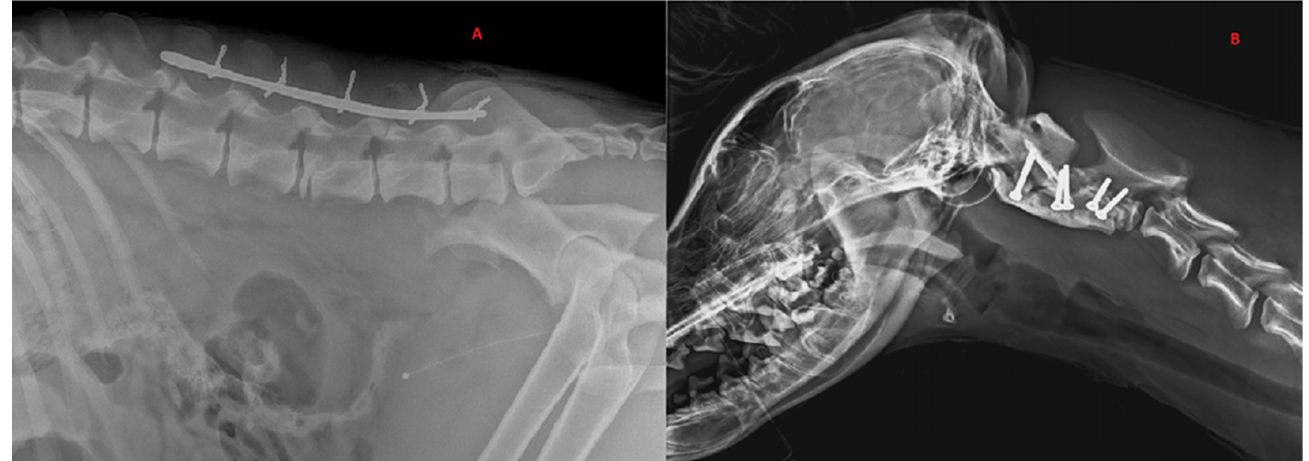
Figure 3. Radiographic exams. ( A ) Application of dorsal spinal staple in 50-month-old, male, Italian wolf with L5 vertebral fracture. Bilateral ileal: body oblique fractures; ( B ) application of ventral implant with screw–PMMA in 7-month-old, female, Italian wolf with C2 vertebral fracture and luxation.